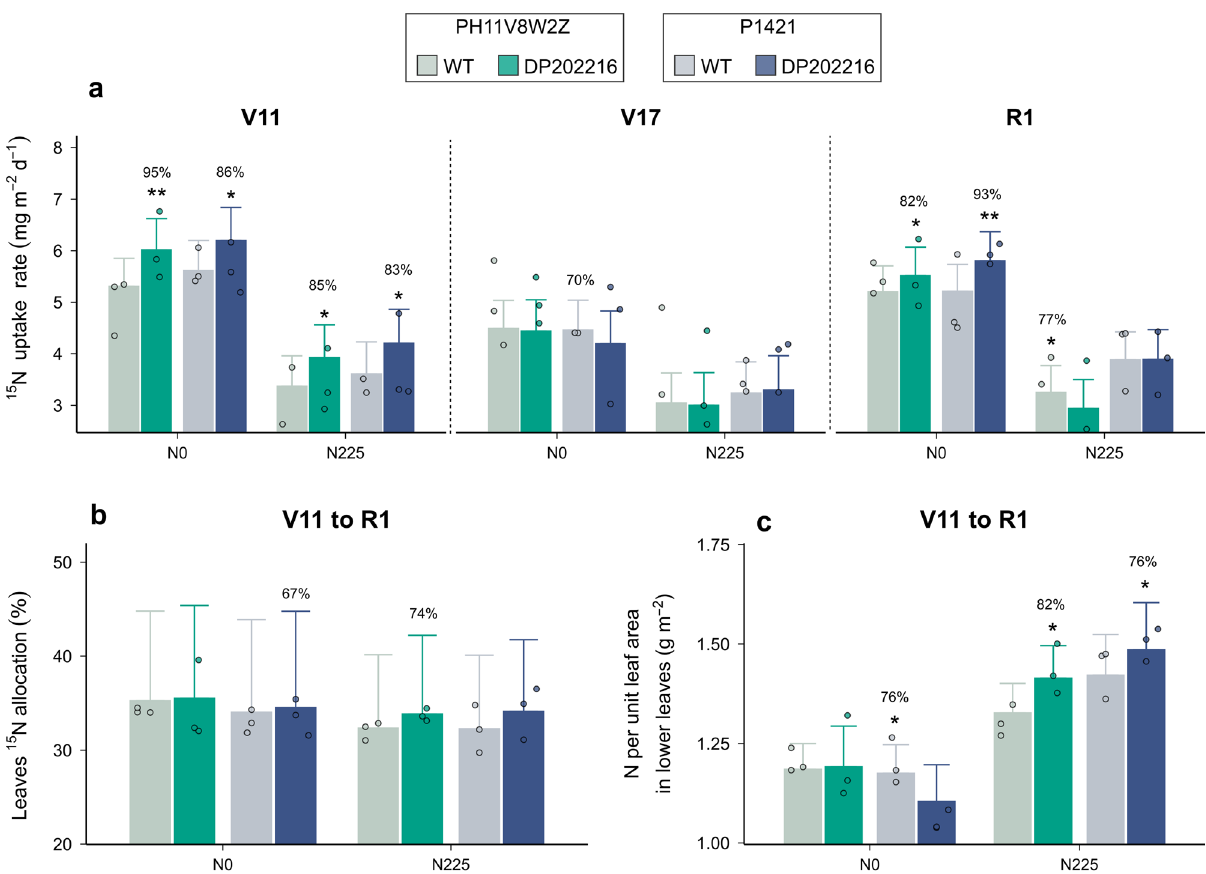
Fig. 1 Plant N traits measured from V11 until fl owering stage on WT and DP202216 fi eld-grown maize hybrids. a Rates of crop 15 N uptake per day measured using short-term labeling at V11, V17, and R1 on two WT and two DP202216 hybrids under 0 (N0) and 225 (N225) kg N ha − 1 conditions ( n = 3 independent samples). b Proportion of 15 N that was allocated to green leaves during the V11-R1 period, expressed in percentage over the total 15 N uptake ( n = 3 independent samples). c Nitrogen per unit leaf area of the lower section of the canopy during the V11-R1 period ( n = 3 independent samples). Bars and whiskers represent the medians and standard deviations of the posterior predictive distribution estimated for the two-year data. Asterisks represent moderate (one) or strong (two) evidence for differences between WT and DP202216 maize